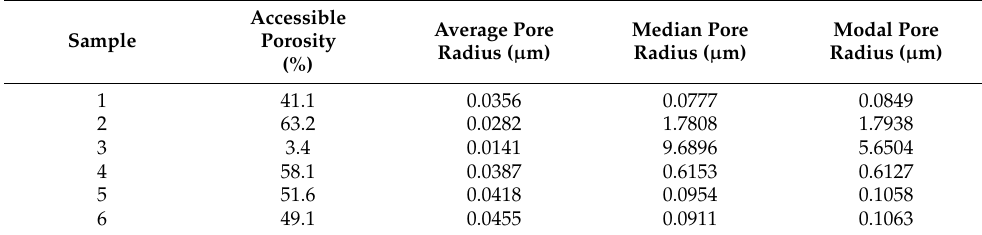
Table 3. Results from mercury intrusion porosimetry.